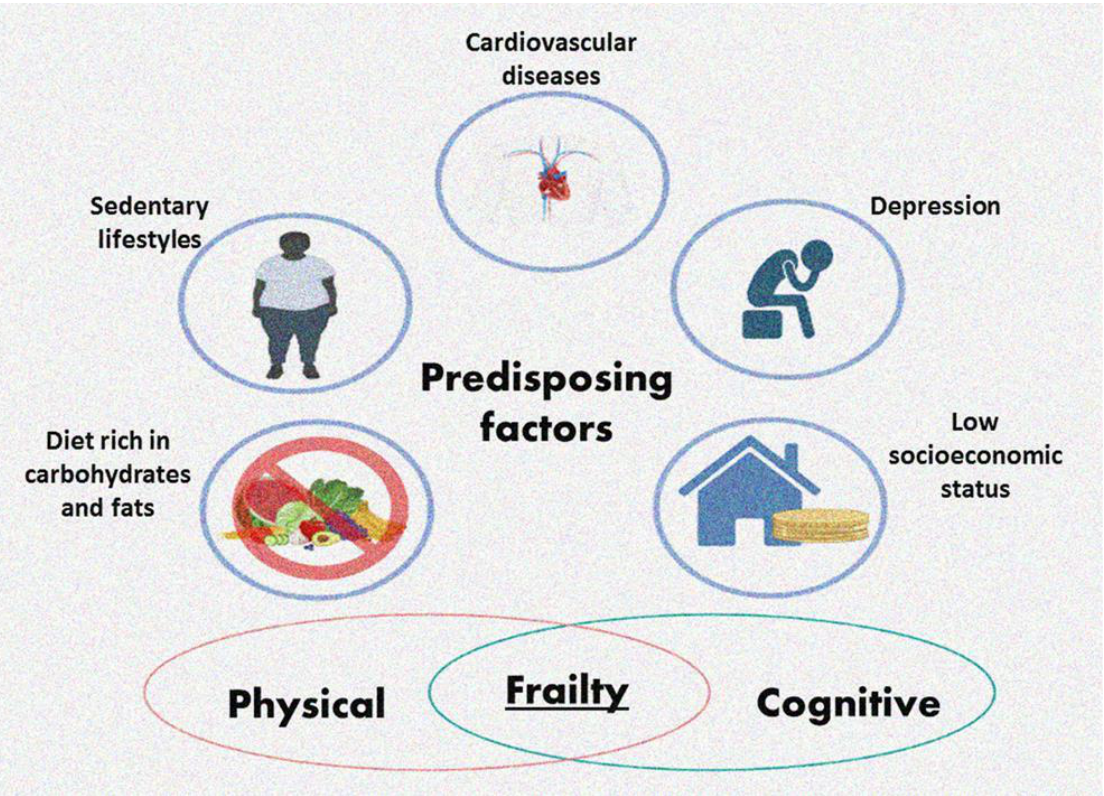
Figure 1. Predisposing factors contributing to the development of frailty.